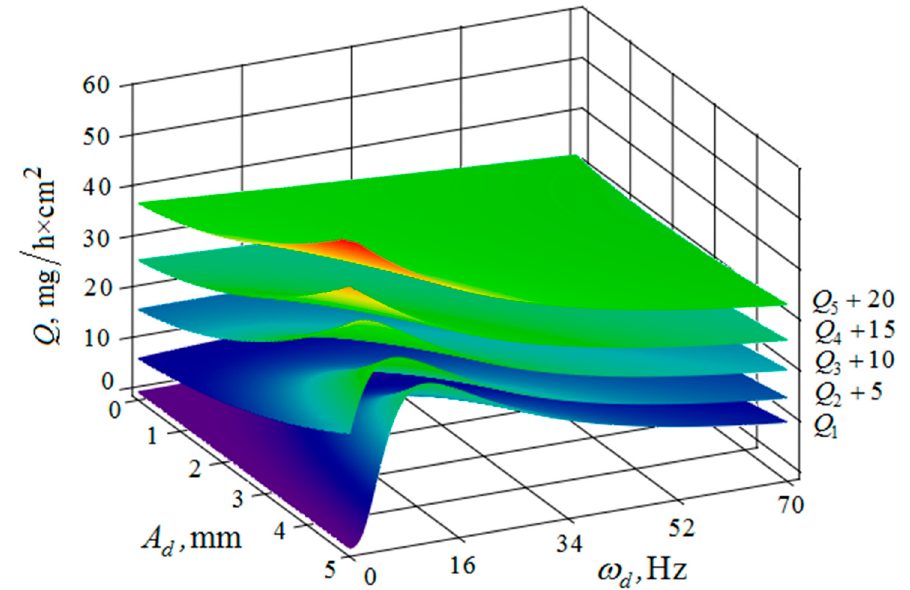
Figure 12. Dependence of the metal removal Q , mg / h · cm 2 on the amplitude of A d , mm and frequency ω d , Hz of oscillations of the processed part surface for various values of the amplitude of oscillations of the reservoir working surfaces: ( Q 1 , Q 2 , Q 3 , Q 4 , Q 5 —metal removal at A r = 1; 2; 3; 4; 5 mm); frequency ω r of oscillations of the reservoir working surface 50 Hz.